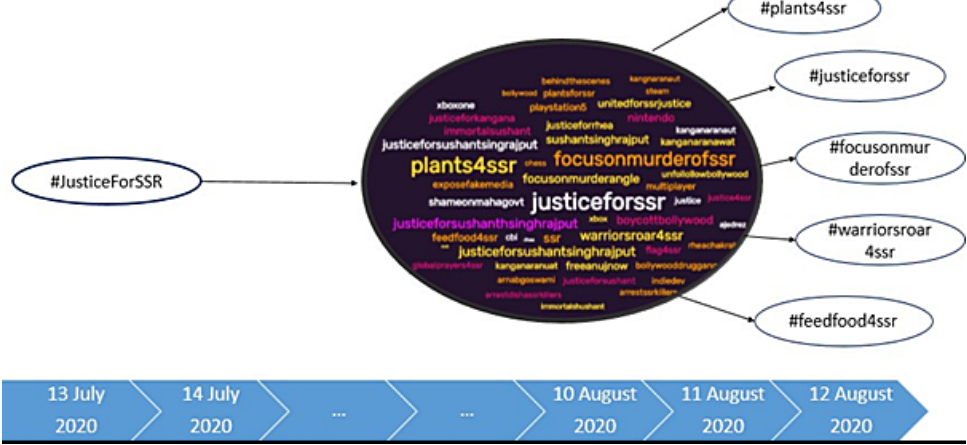
Figure 11. Viral Hashtags detection using initial hashtag